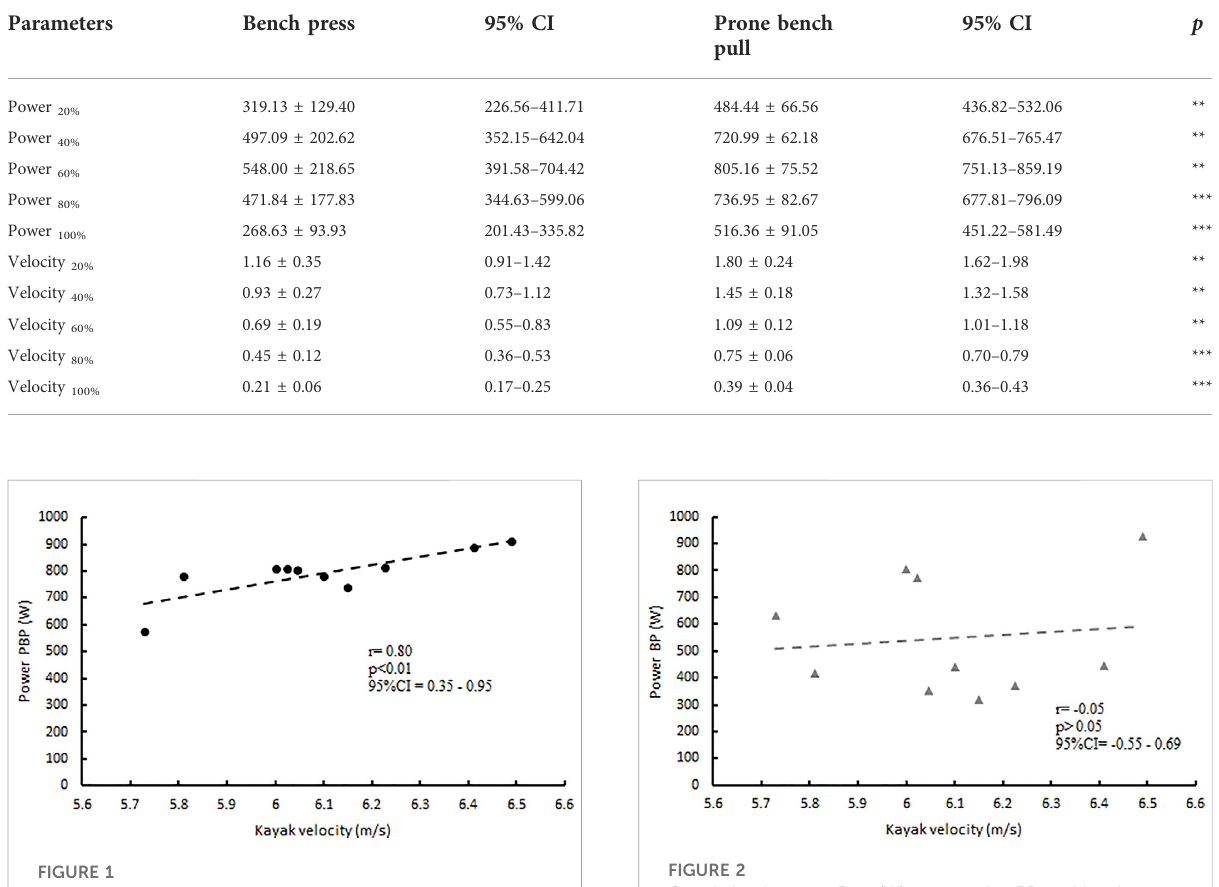
FIGURE 2 Correlation between P max (W) expressed at BP, and kayak velocity (m/s) reached on KTS